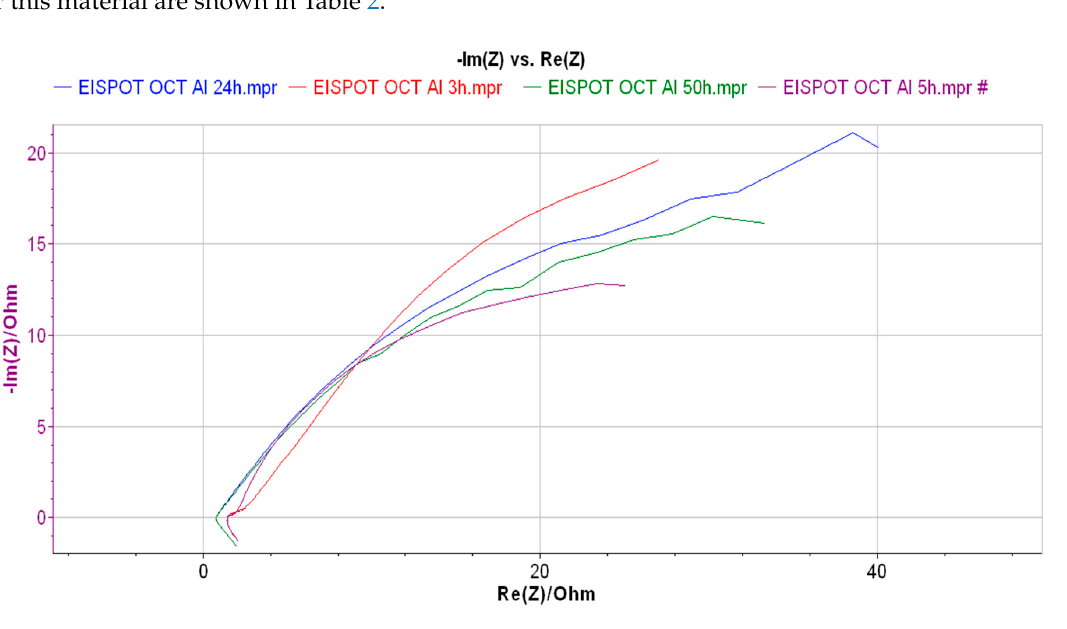
Figure 2. Nyquist plots of OCT immersed chloride molten salt at 3, 5, 24, and 50 h. Table 2. Electrochemical parameters obtained for electrochemical impedance spectroscopy (EIS) tests in OCT alloy.